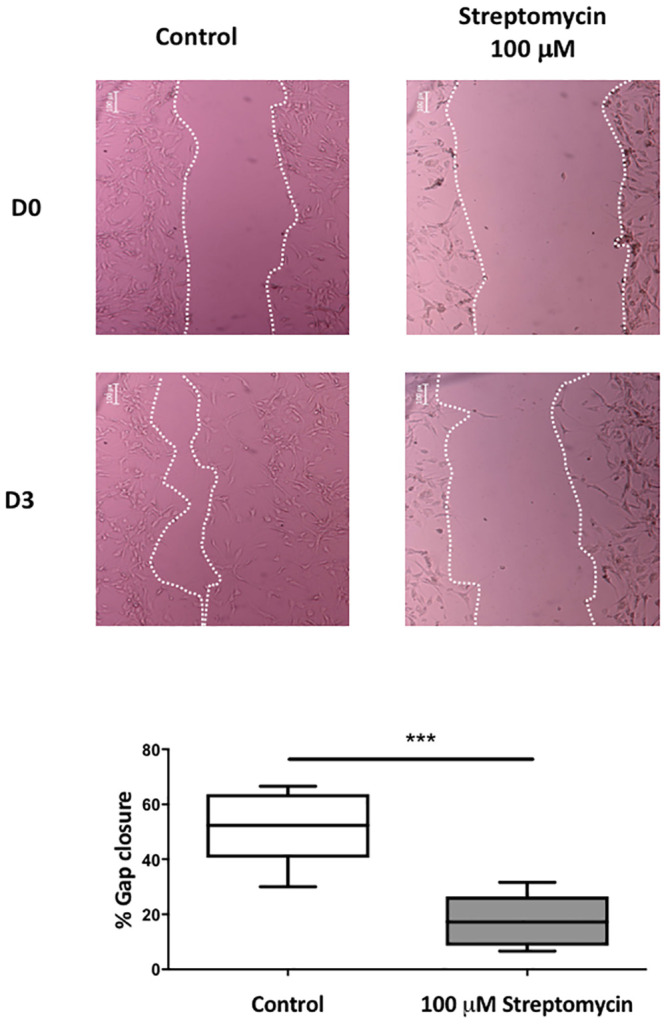
Effect of streptomycin on VICFB migration in a cell-culture scratch assay.Phase-contrast microscopy image of scratch assays, showing VICFB and scratch edge on Day-0 (top row) and Day-3 (bottom row) in the absence (control) and presence of 100 μM streptomycin. Scratch edge in each panel is indicated by the white dotted-line. Quantification of migration (day-3) in the control and streptomycin treated cells is shown the lower panels (n = 6 patients; *** = p<0.001).